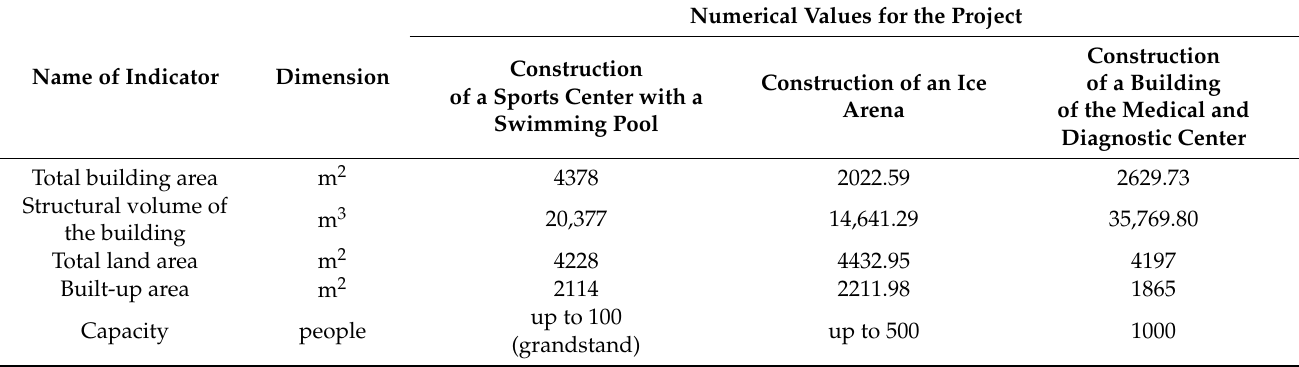
Table 5. Technical parameters of